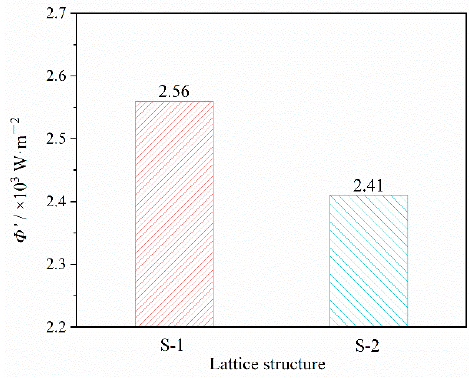
Figure 8. Thermal flux of S ‐ 1 and S ‐ 2.